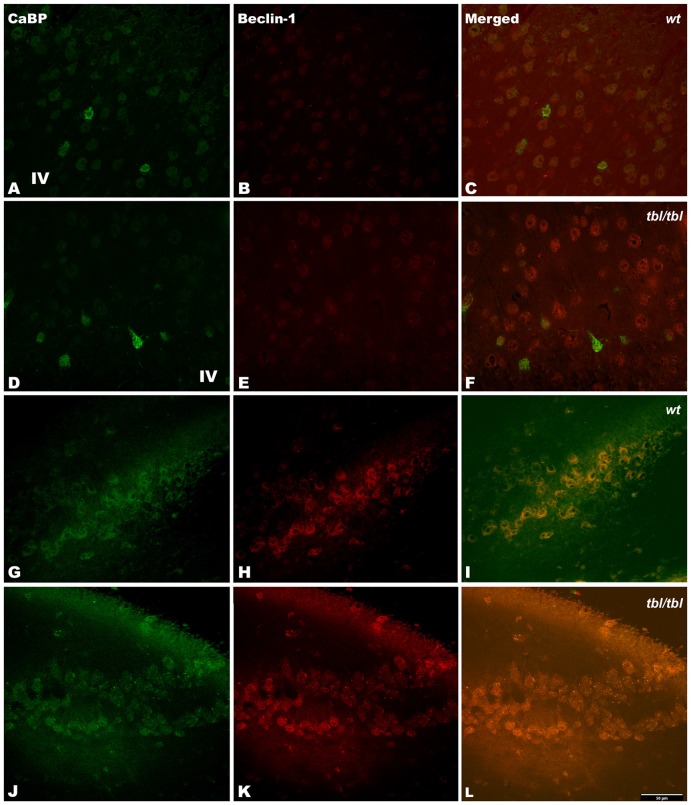
Confocal images of coronal sections through the frontal cortex layers II-III (A–C) and CA3 hippocampus (G–I) of 4-month-old wt mice, and the same neocortical (D–F), and hippocampal region (J–L) of 4-month-old tbl/tbl mice. Beclin-1 expression is most pronounced in tbl/tbl brains (B,K), and as in wt co-express with calbindin (CaBP) inmmunoreactive and non-immunoreactive cell bodies (C,F,I,L). IV, layer IV. Bars = 50 μm.